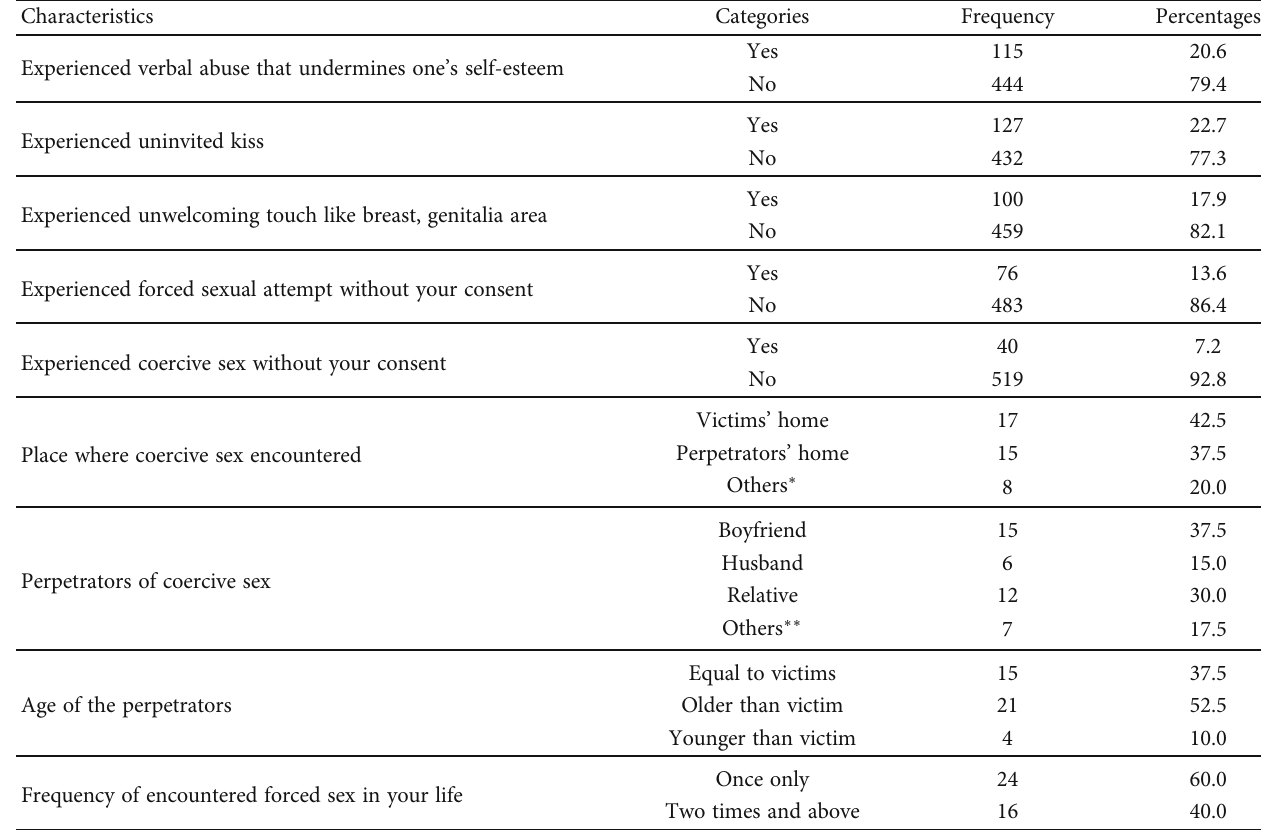
Table 3: Characteristics of sexual violence among high school female students in Jarso district, Oromia region, eastern Ethiopia, 2019 ( n = 559